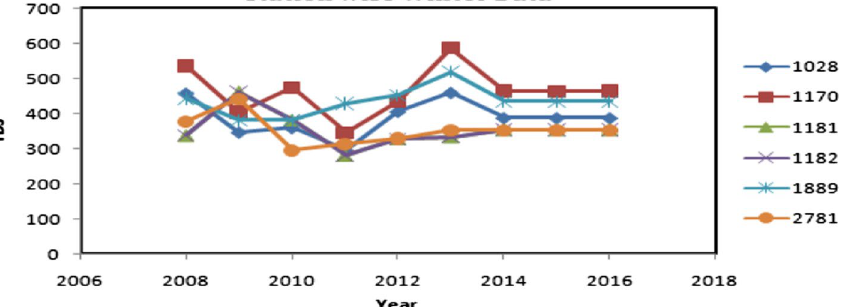
Fig. 10 Year-wise data of TDS at each station for winter